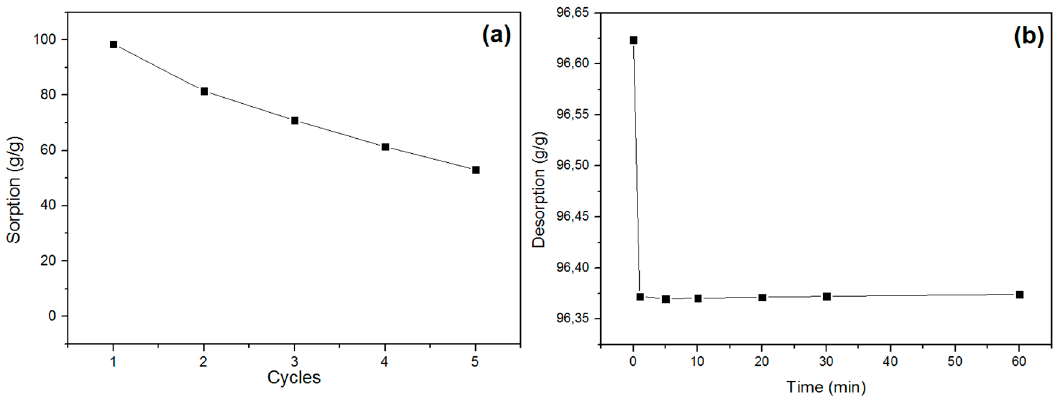
Figure 5. Recycling ( a ) and desorption ( b ) tests for CPNaOHT using petroleum.